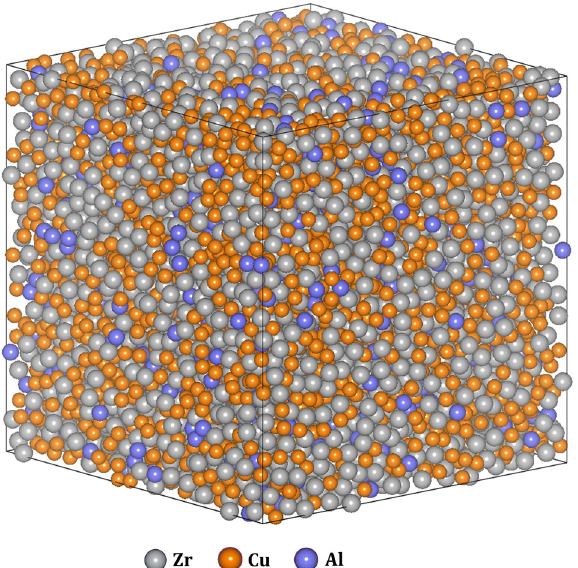
Fig. 1 Atomic con fi guration of MD-simulated Zr 46 Cu 46 Al 8 MGs (see ref. 13 for the simulation method and interatomic potential used)